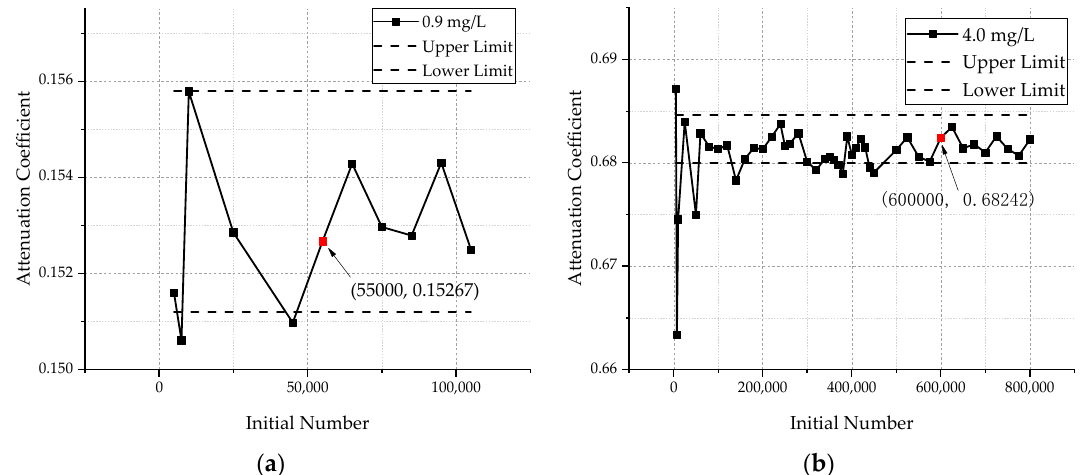
Figure 5. Mean value of the extinction coefficient by using different initial photon numbers when the concentrations are ( a ) 0.9 mg/L and ( b ) 4.0 mg/L. Table 5. Initial photon number for seawater containing different suspended matter concentrations.